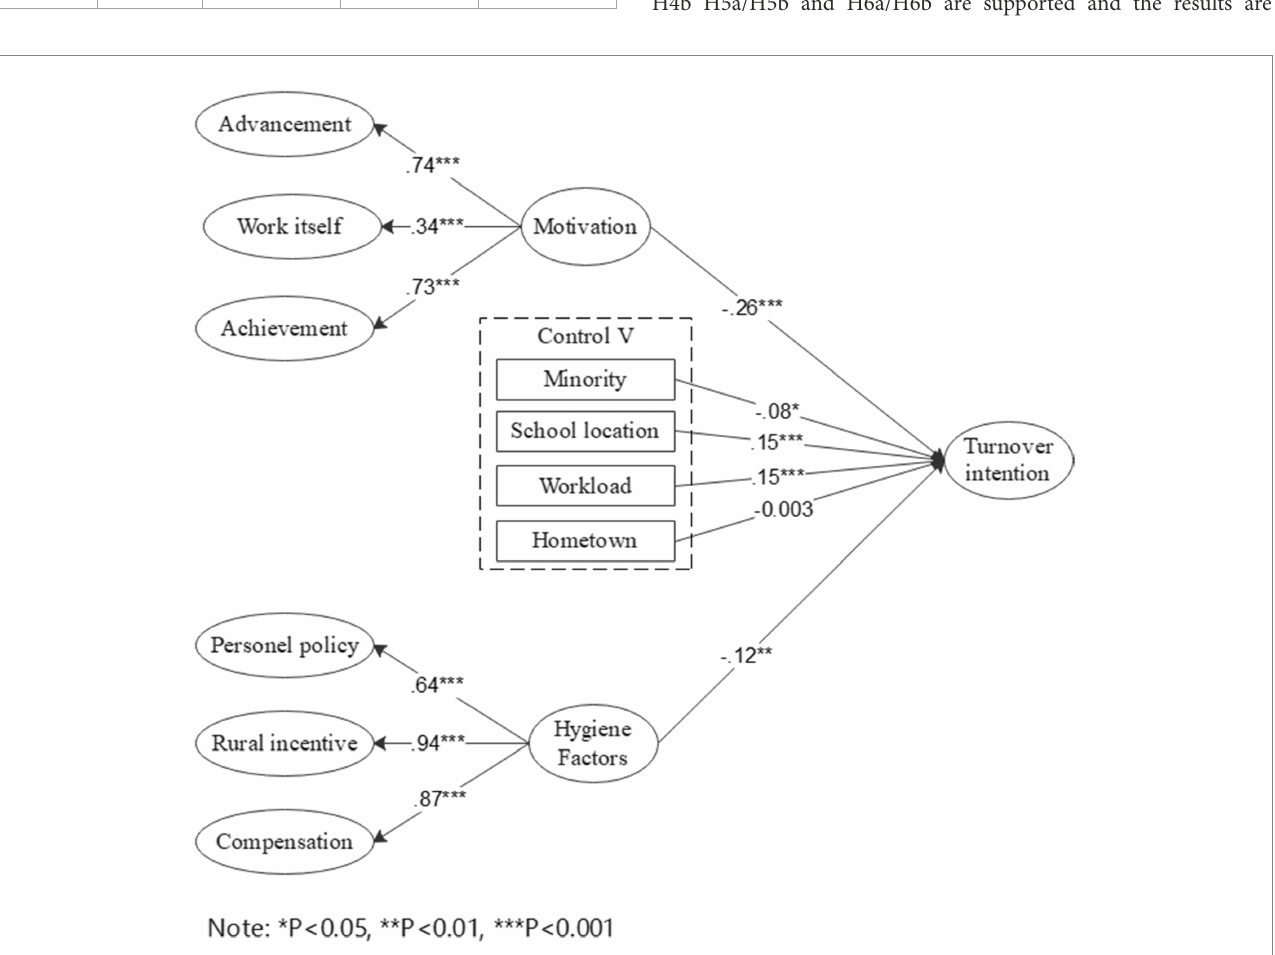
FIGURE 2 Standardized estimates from structural equation models for teachers’ turnover tendency in Western Rural